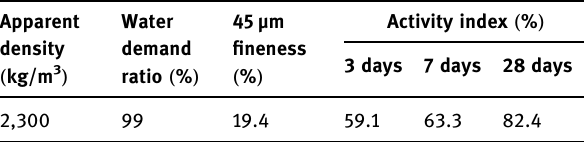
Table 2: Physical properties of fl y ash Apparent